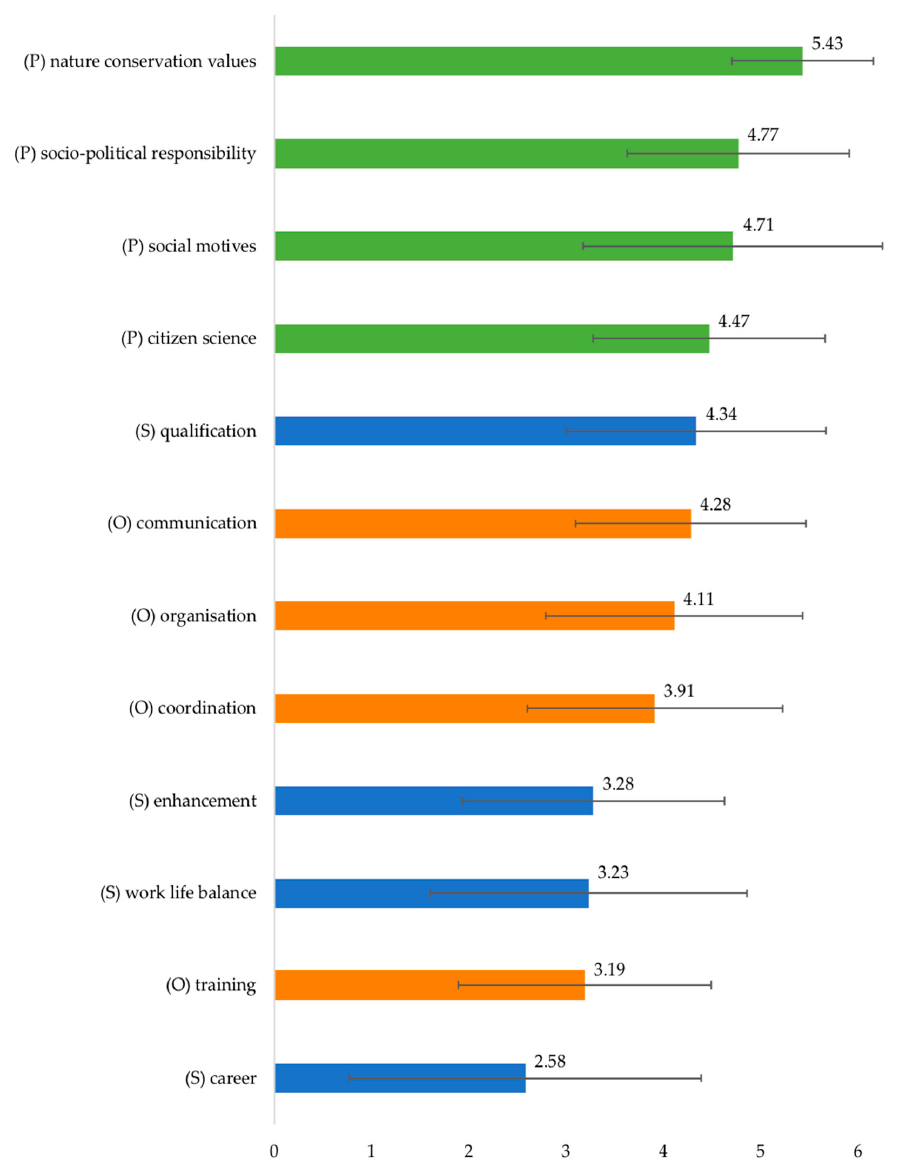
Figure 2. Functions for participating in the project Insects of Saxony, N = 116. Six-point scale: 1 = does not apply at all 6 = fully applies; mean values (coloured bars) and standard deviations (error bars). In descending order: (P) (green bars) = pro-social functions, (S) (blue bars) = self-serving functions, (O) (orange bars) = organisational functions.